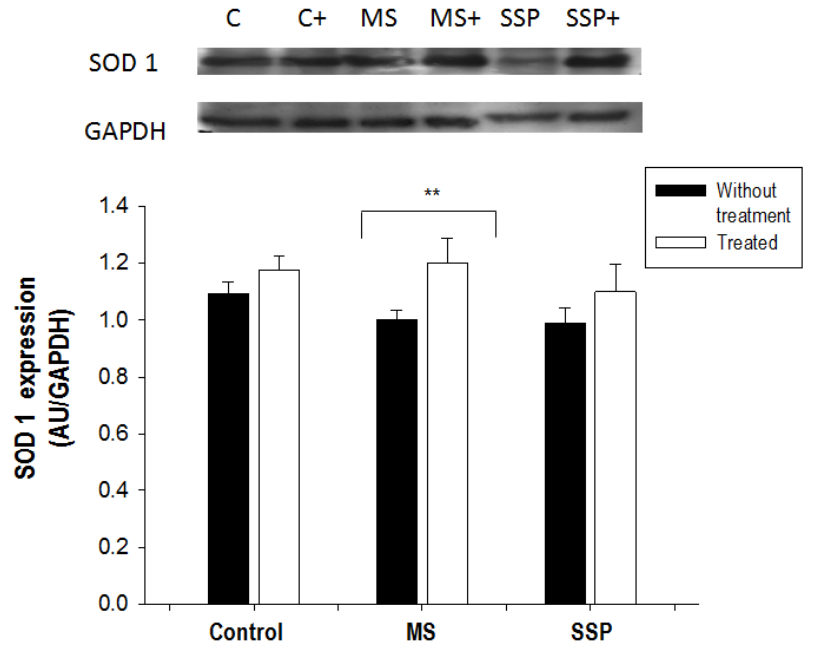
Figure 6. Changes caused by treatment for 1 month (from 6 to 7 months of age) with RSV / QSC of the superoxide dismutase 1 (SOD 1) expression in the aortic tissue caused by short- (SP) and long- (MS) term exposure to sucrose. A representative Western blot image is shown. Data represent the mean ± SEM of six different rats from each group. ** p < 0.05. Abbreviations: C = control; C+ = control treated with polyphenols; MS= metabolic syndrome; MS+ = metabolic syndrome treated with polyphenols; SSP = short sucrose period; SSP+ = short sucrose period treated with polyphenols. SOD2 was significantly decreased in aortic tissue from the MS and SSP groups (Figure 7). The RSV/QSC treatment only decreased the expression of SOD2 in the control group that did not receive sucrose (Figure 7).